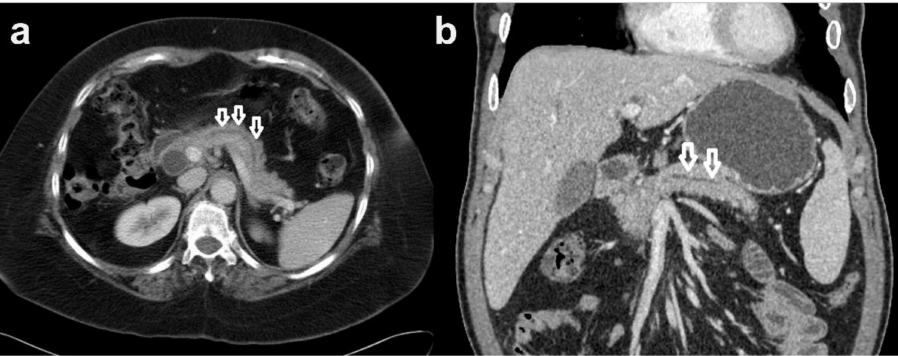
Figure 3. Pancreatic duct dilatation on CT scan. ( a ) CT scan - axial view of pancreatic duct dilatation. ( b ) CT scan - coronal view of pancreatic duct dilatation.